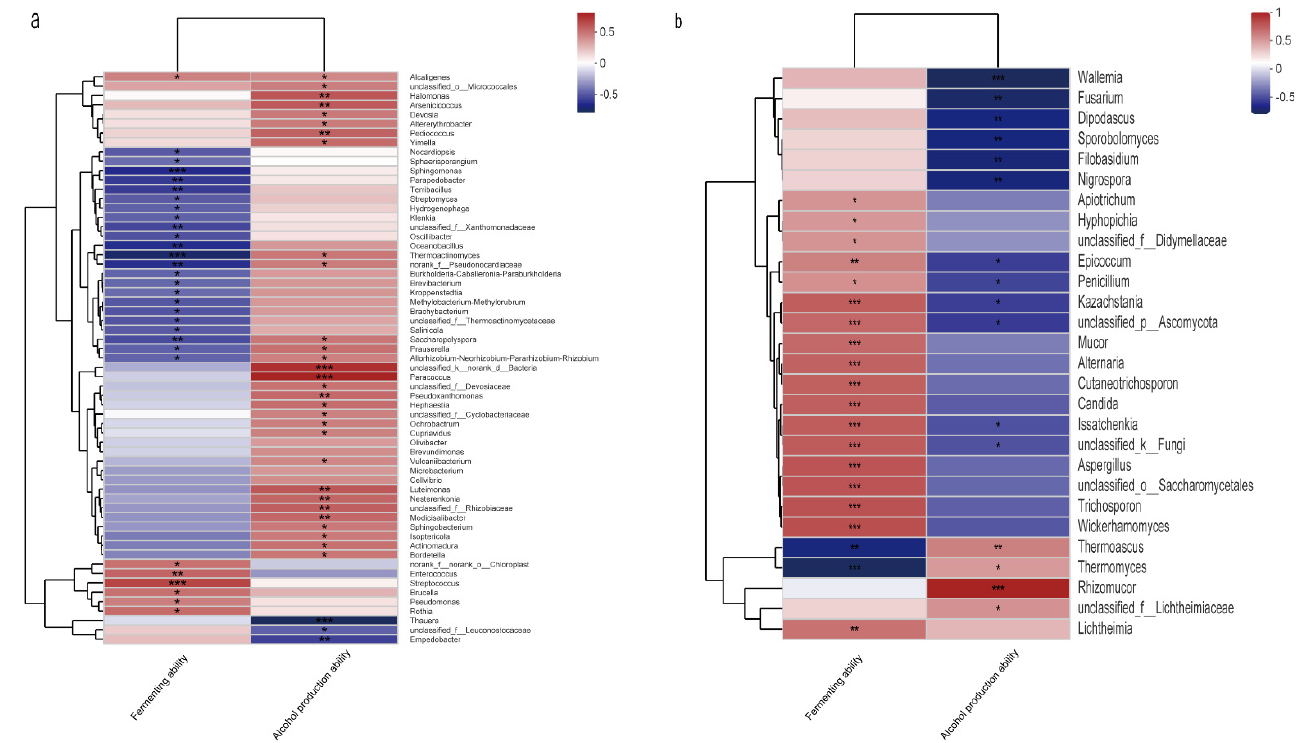
Figure 2. Heatmap of correlation analysis between Daqu microbiota and the fermentation ability and alcohol production ability. ( a ) Bacterial genera. ( b ) Fungal genera (|R| > 0.4, p < 0.05, * 0.01 < p ≤ 0.05, ** 0.001 < p ≤ 0.01, *** p ≤ 0.001).